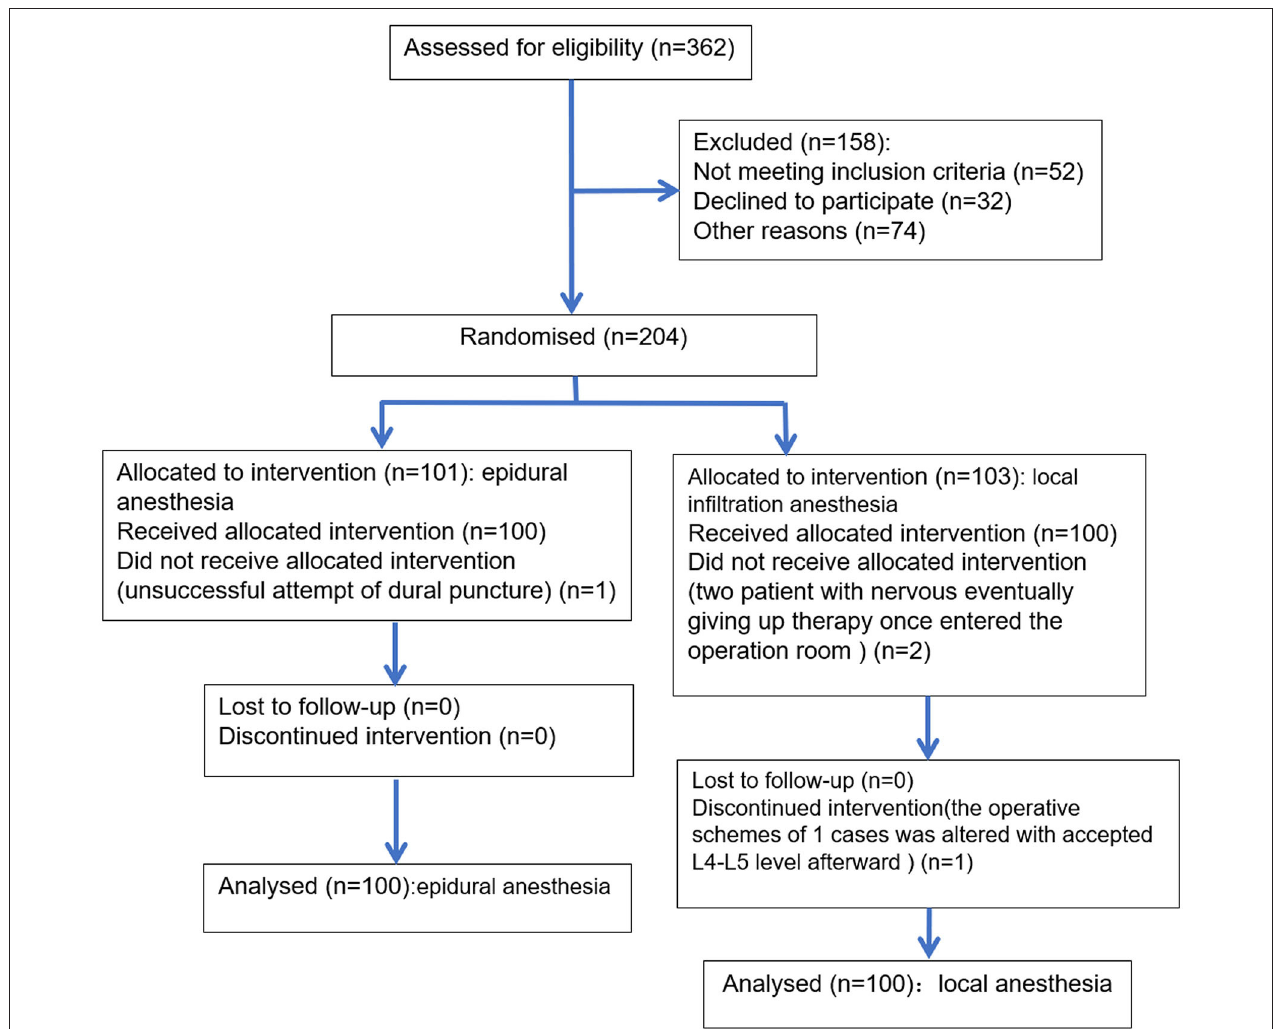
FIGURE 1 | Flowchart of selection